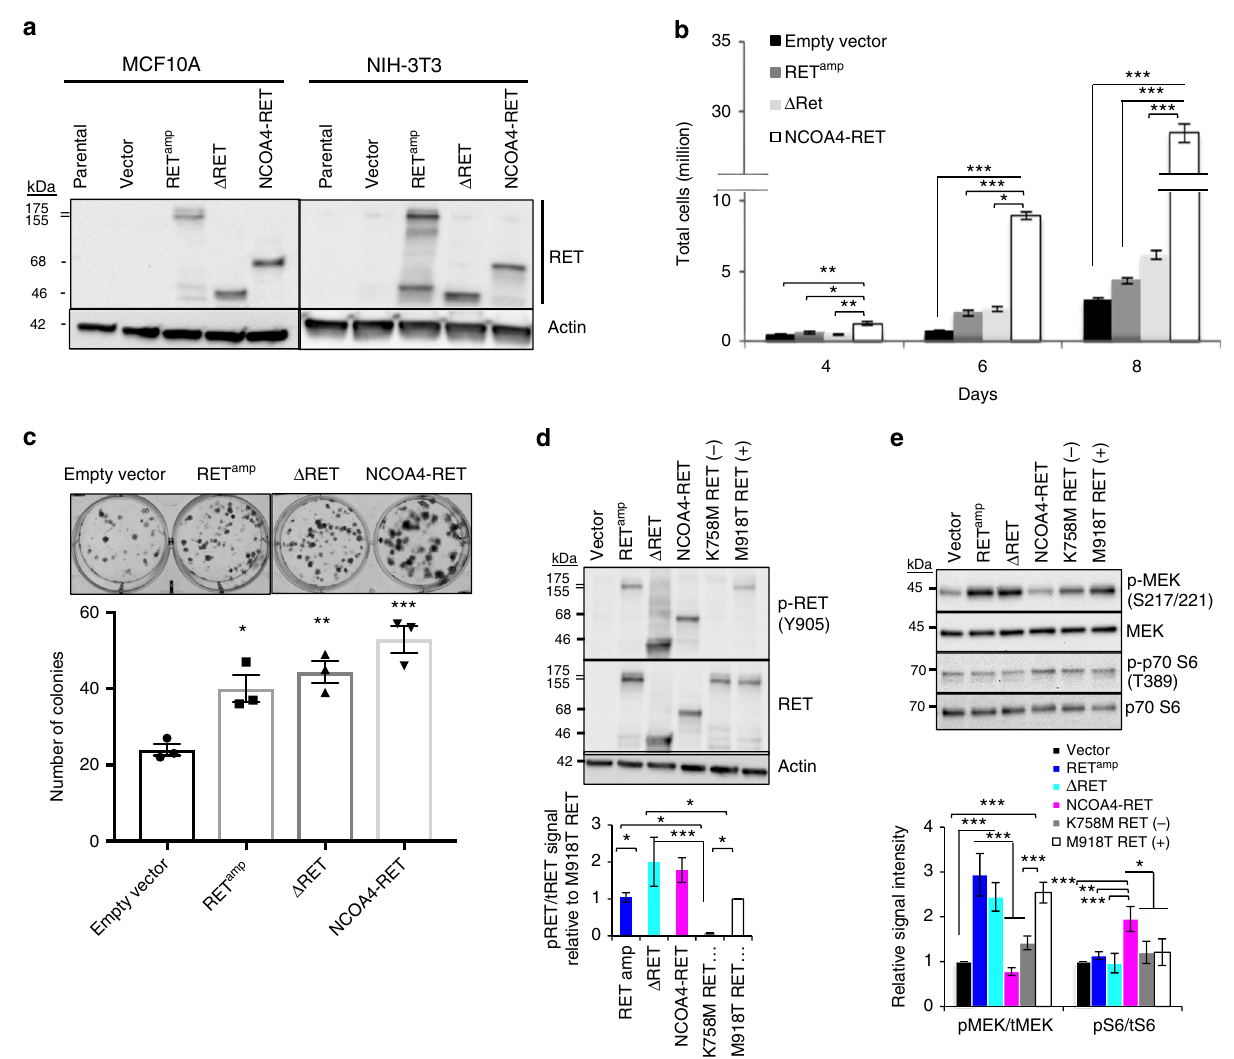
Fig. 2 Transforming activity and oncogenic signaling of RET alterations. a MCF10A (human breast epithelial) and NIH/3T3 (immortalized mouse fi broblasts) cells overexpressing RET wild-type (RET amp ), NCOA4-RET, and Δ RET. Expressed proteins were detected using a C-terminal RET antibody at predicted sizes of 155/175, 68, and 46 kDa respectively. NIH/3T3 cells transduced with RET amp , NCOA4-RET, and Δ RET show increased b growth rates and c clonal expansion compared to cells transduced with vector alone. For growth curve experiments, 20,000 cells were plated per dish in triplicate for all cell lines and counted at days 4, 6, and 8. For clonogenic studies, 150 cells were plated per well in triplicate for all cell lines and stained with crystal violet at the end of 14 days. d Immunoblot analysis of NIH/3T3 cells overexpressing RET amp , Δ RET, and NCOA4-RET reveal phosphorylation at tyrosine 905 and e downstream signaling measured after serum starvation for 24 h. In ( d ) and ( e ), kinase inactive mutant (K758M) and constitutively active mutant (M918T) refer to full-length RET variants used as negative and positive controls respectively. Results shown are representative of experiments performed thrice and error bars indicate s.d. ( n = 3). p ≤ 0.05 (*), ≤ 0.01 (**), ≤ 0.001 (***) are statistically signi fi cant and analyzed by ANOVA and Tukey ’ s multiple comparisons test. Open-ended brackets depict comparison between the indicated group(s) and each of the groups under the bracket. Where brackets are absent, comparison is with empty